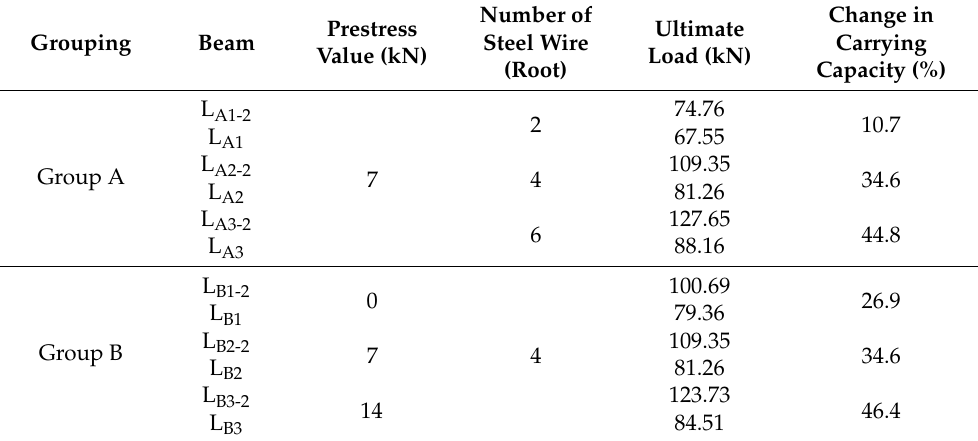
Table 4. The comparison information of ultimate load between regulated beam and short-term beam.